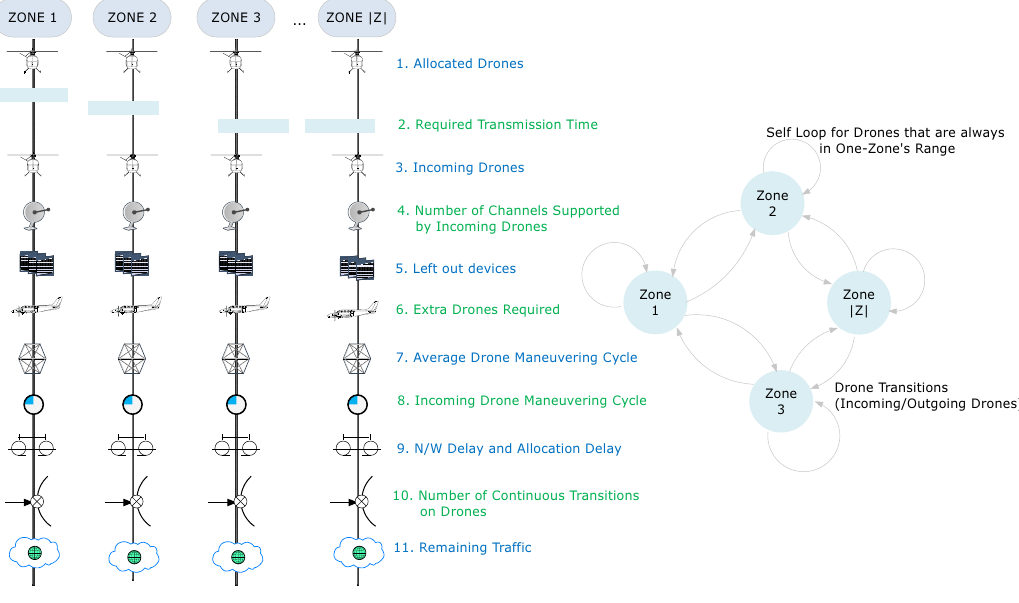
Figure 3. An overview of drone modeling and traffic estimation via network state